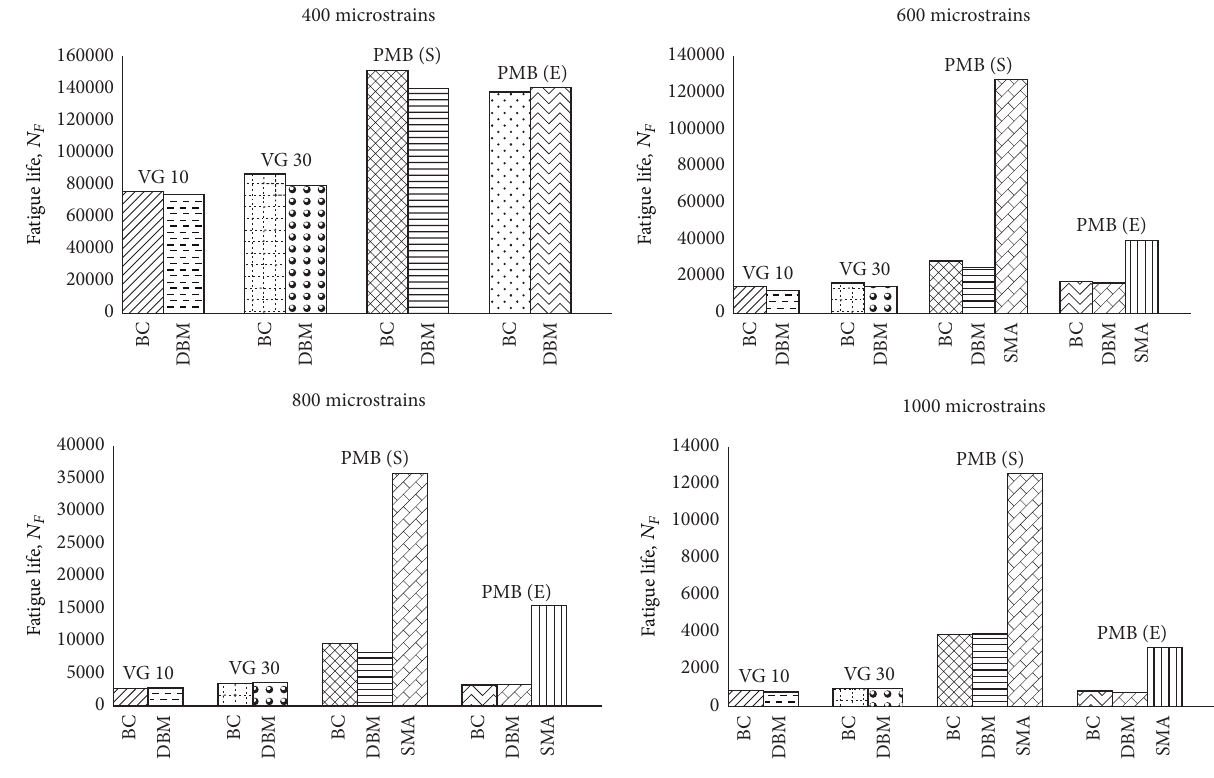
Figure 6: Fatigue life at different strain levels. Table 5: Results of Marshall Mix